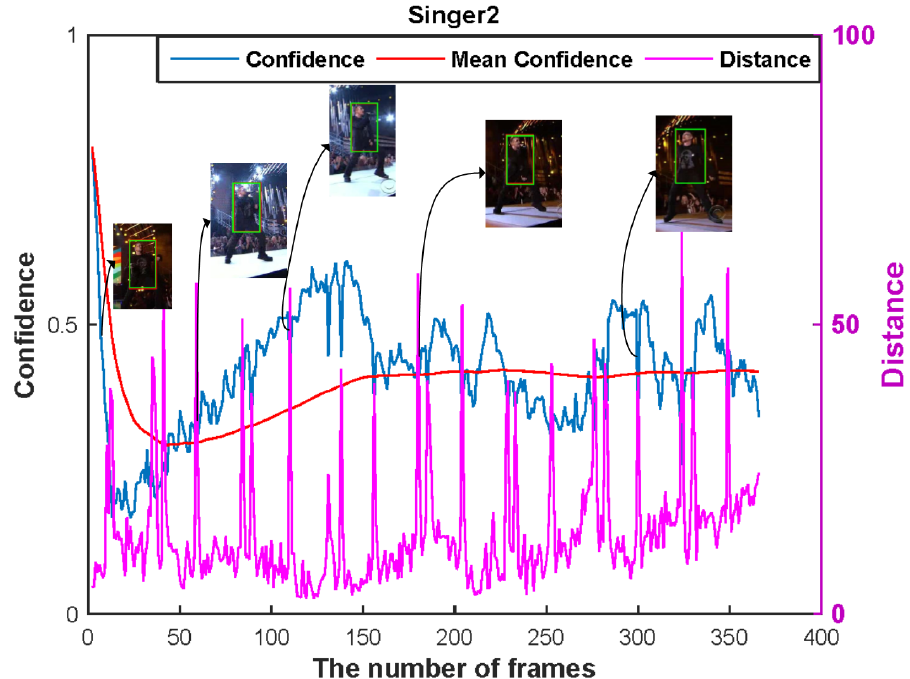
Figure 3. Visualization of the relationship between the confidence and similarity distance on Singer2. Even if the target’s pose or appearance changes significantly (purple curve), the confidence of the current predicted result (blue curve) is still higher than the mean confidence (red